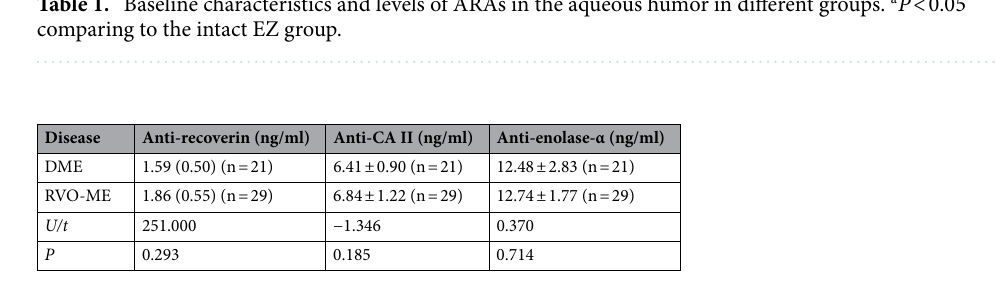
Table 2. Levels of ARAs in the aqueous humor of DME patients and RVO-ME patients.